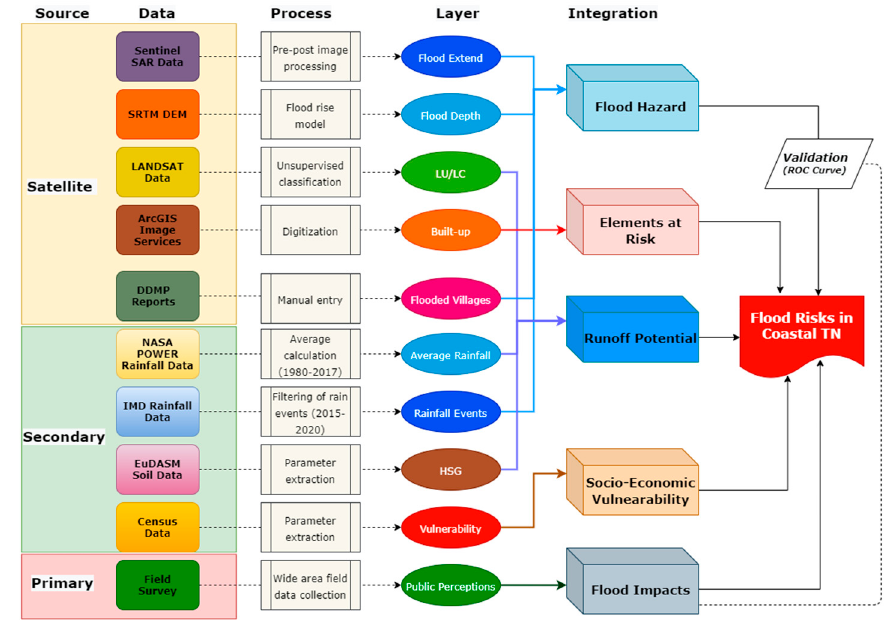
Figure 2. Schematic representation of the methodology adopted in the study . Table 1. Window periods for Sentinel-1 median images extraction before and after the major floods . Year Before Flood After Flood